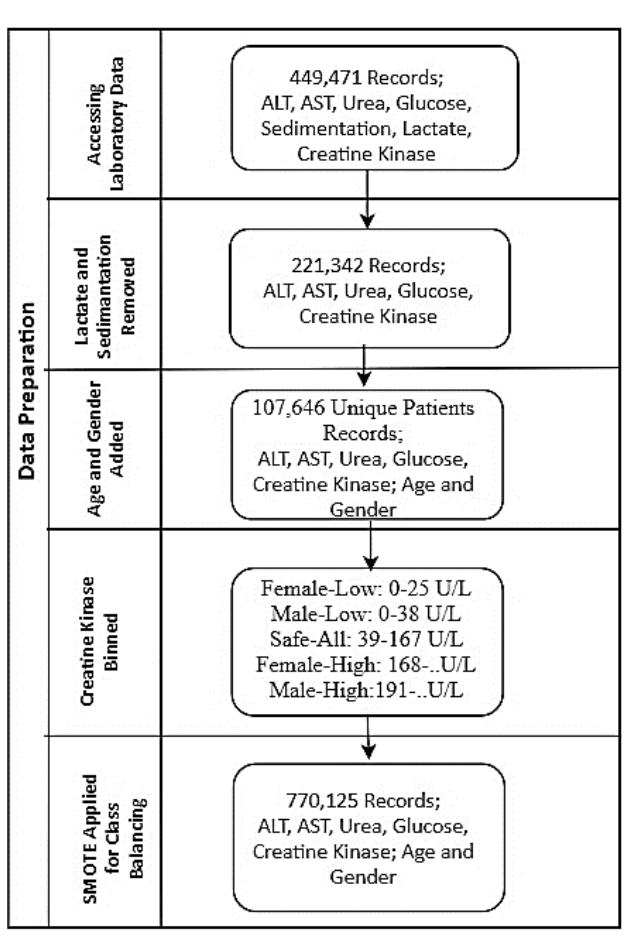
Figure 3. Summary of data